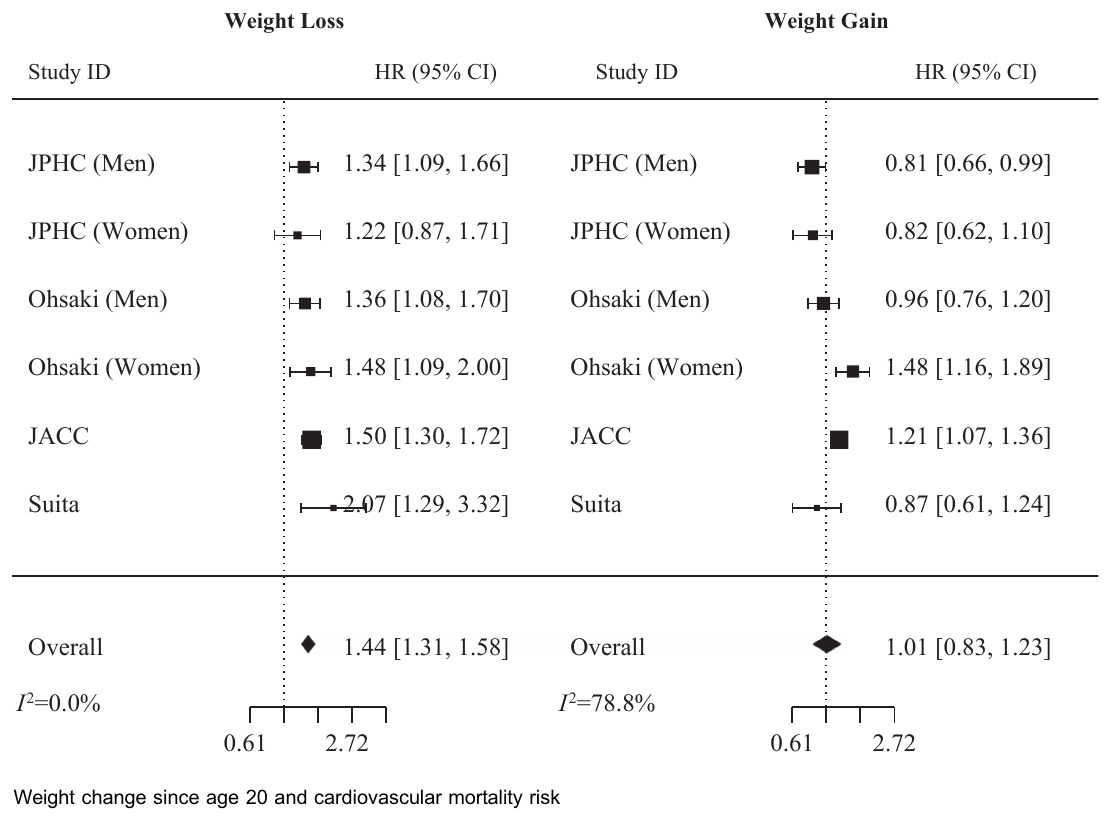
Fig. 1 Weight change since age 20 and cardiovascular mortality